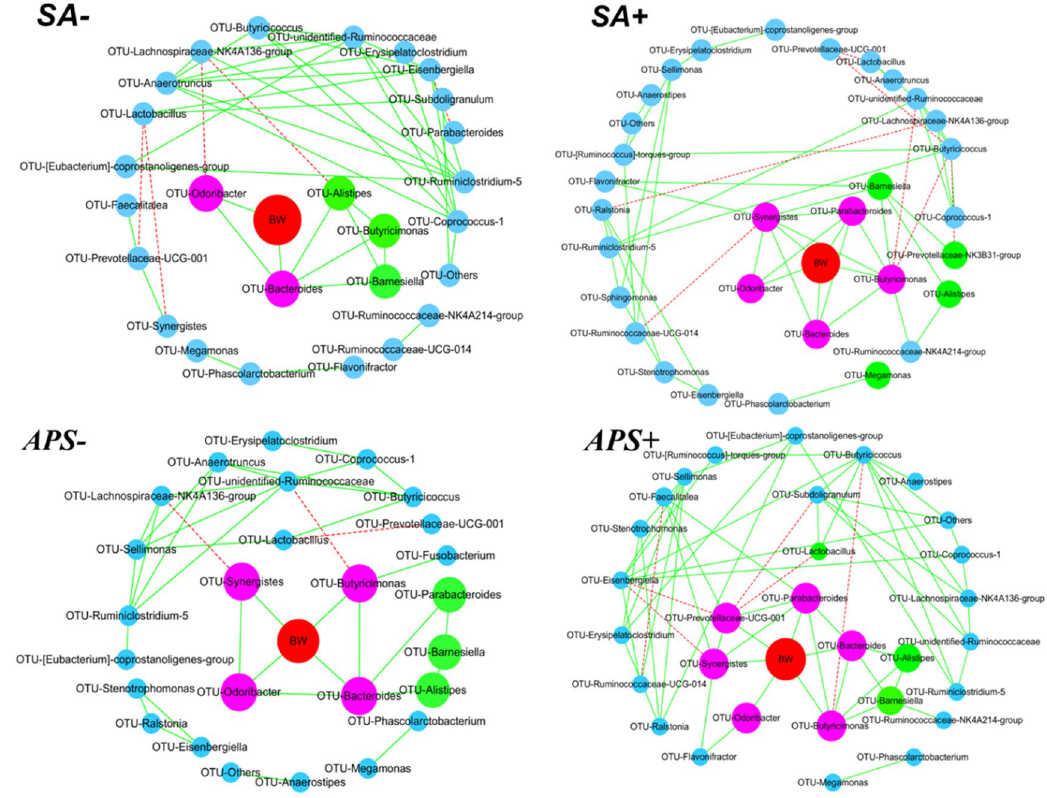
Figure 6. Co-occurrence network of cecal microbes and body weight (BW) in broilers challenged with S. ser. Enteritidis or dietary APS supplementation were made using cytoscape (3.8.2), https:// cytos cape. org/. Here, we display the interactions among intestinal microbes at the genus level. The core bacteria (purple nodes) that are directly related to BW (red nodes) and the biomarker bacteria (green nodes) that interact (through synergy or mutual exclusion) with the core bacteria are shown. The abundance values of microbes connected with BW by a solid green line have a direct positive correlation with BW. Two microbes connected with a solid green line have a positive correlation, with a Spearman’s rank correlation coefficient higher than 0.60. Microbes connected with a dashed red have a negative relationship, with a Spearman’s rank correlation coefficient less than -0.60. SA-